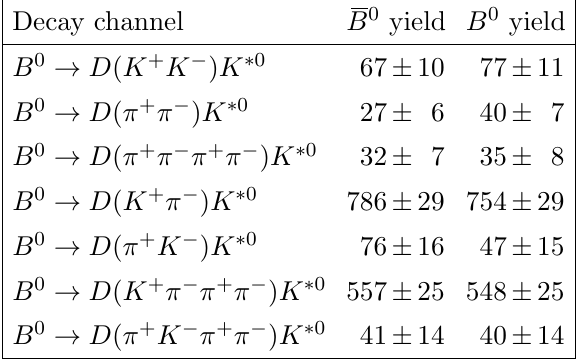
Table 1 . Summary of signal yields. The uncertainties are